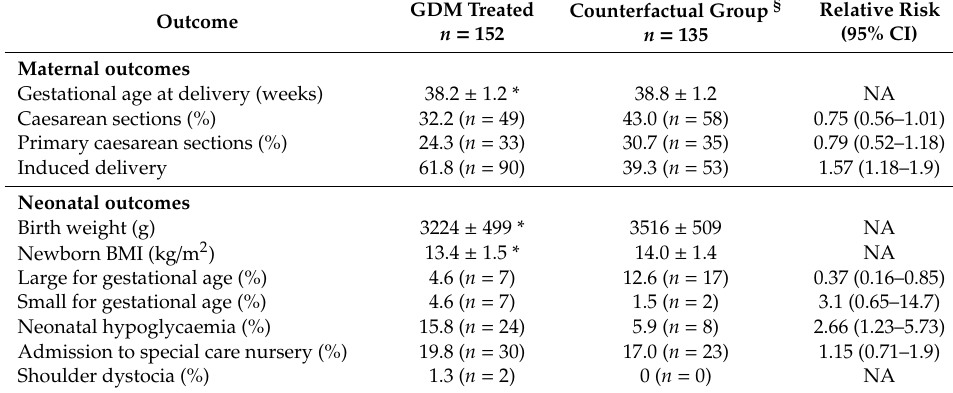
Neonatal outcomes Birth weight (g)